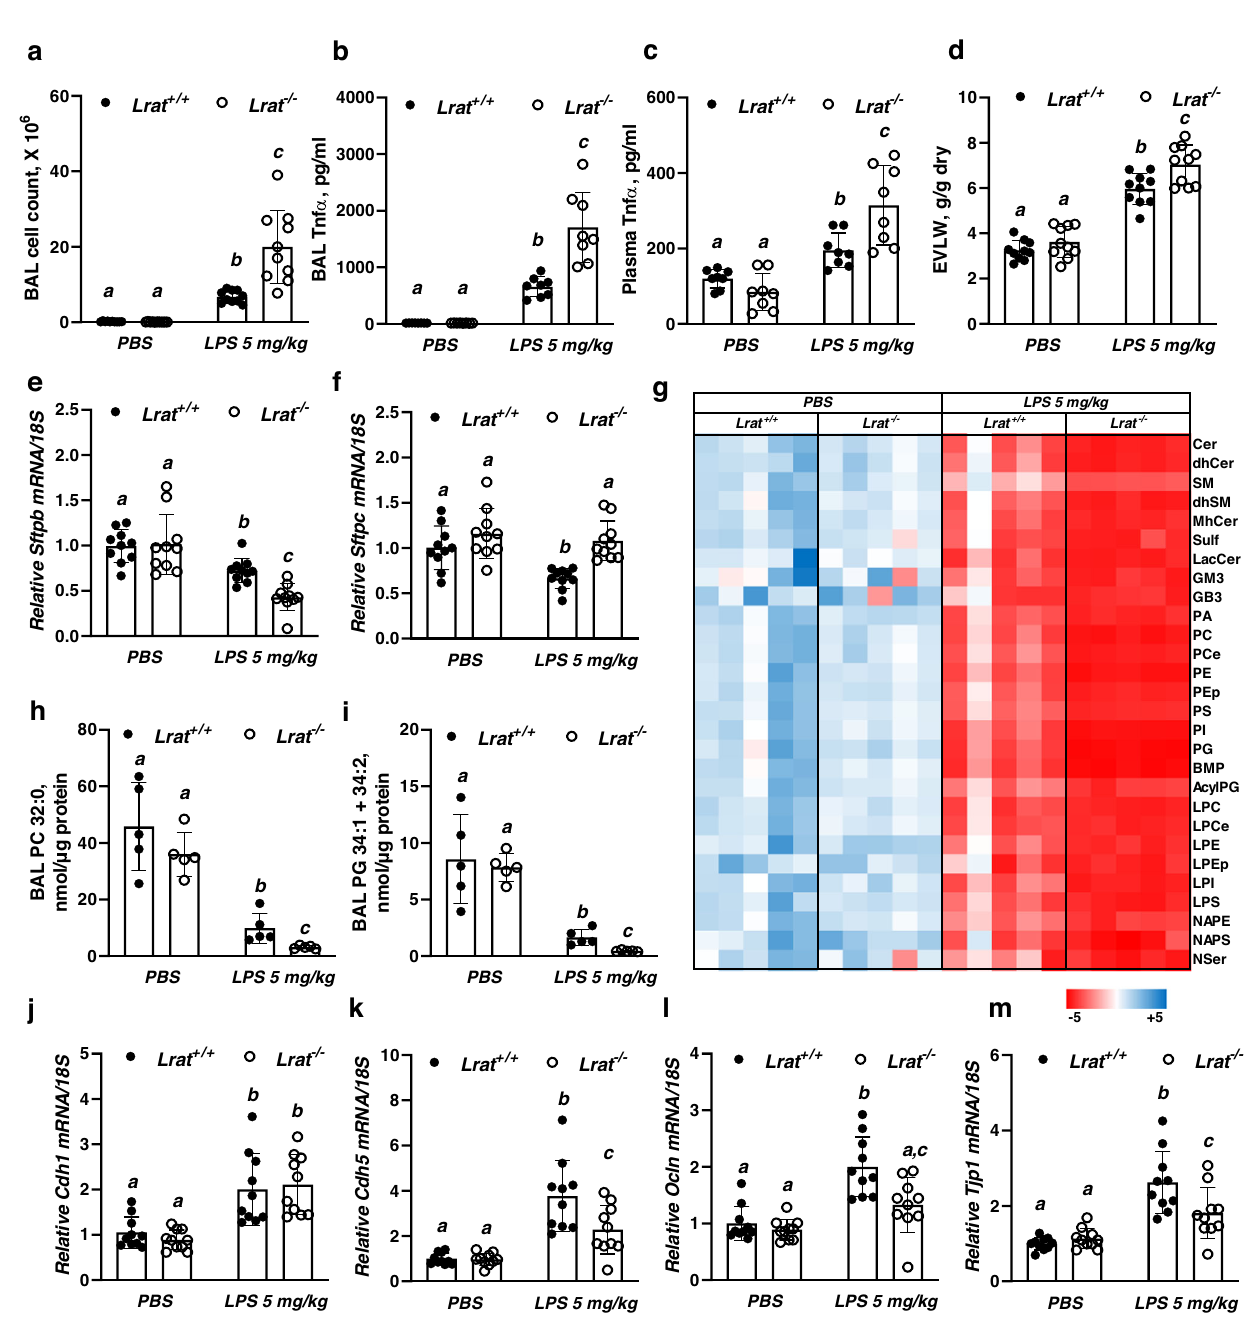
Fig. 4 | Postprocessing analysis of single-cell RNA-seq datasets of mouse lung stromal retinoid-containing cells.a UMAPvisualization ofstromalcell clustering inferred from mouse lung retinoid-containing cell scRNA-seq datasets; Three retinoid-containing lipo fi broblast clusters (proliferative, conventional, and myo fi broblast-committedlipo fi broblasts)areannotated. b Dotplotvisualizationof marker gene expression of lung fi broblasts (alveolar and adventitial, Col13 + and Col14 + , lipo fi broblasts, and myo fi broblasts) in stromal clusters from retinoid- containing cell scRNA-seq datasets. The x -axis (Features) gives gene names, the y - axis(Identity)indicatesclusternumbers.Thelevelofexpressionisspeci fi edbythe